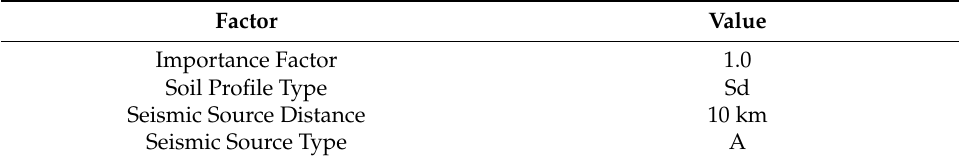
Table 5. Seismic factor values.